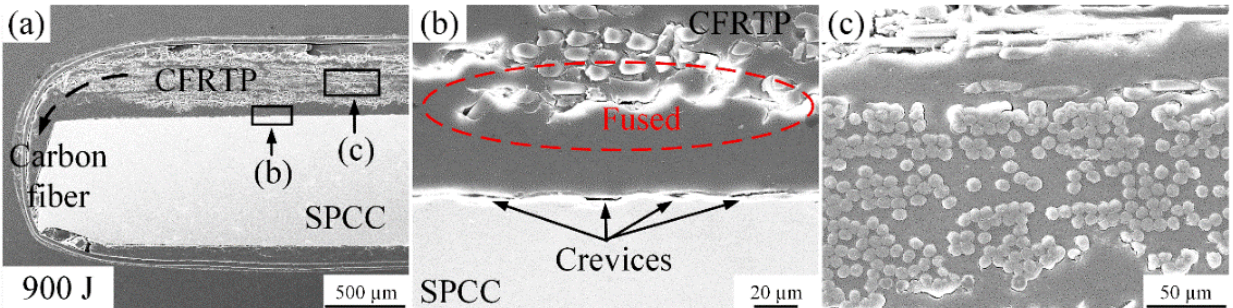
Figure 9. Microstructure of the joint cross-section at the 900 J energy: ( a ) carbon fibers squeezed out phenomenon; ( b ) situation of interface 1 and 2; ( c ) carbon fibers.